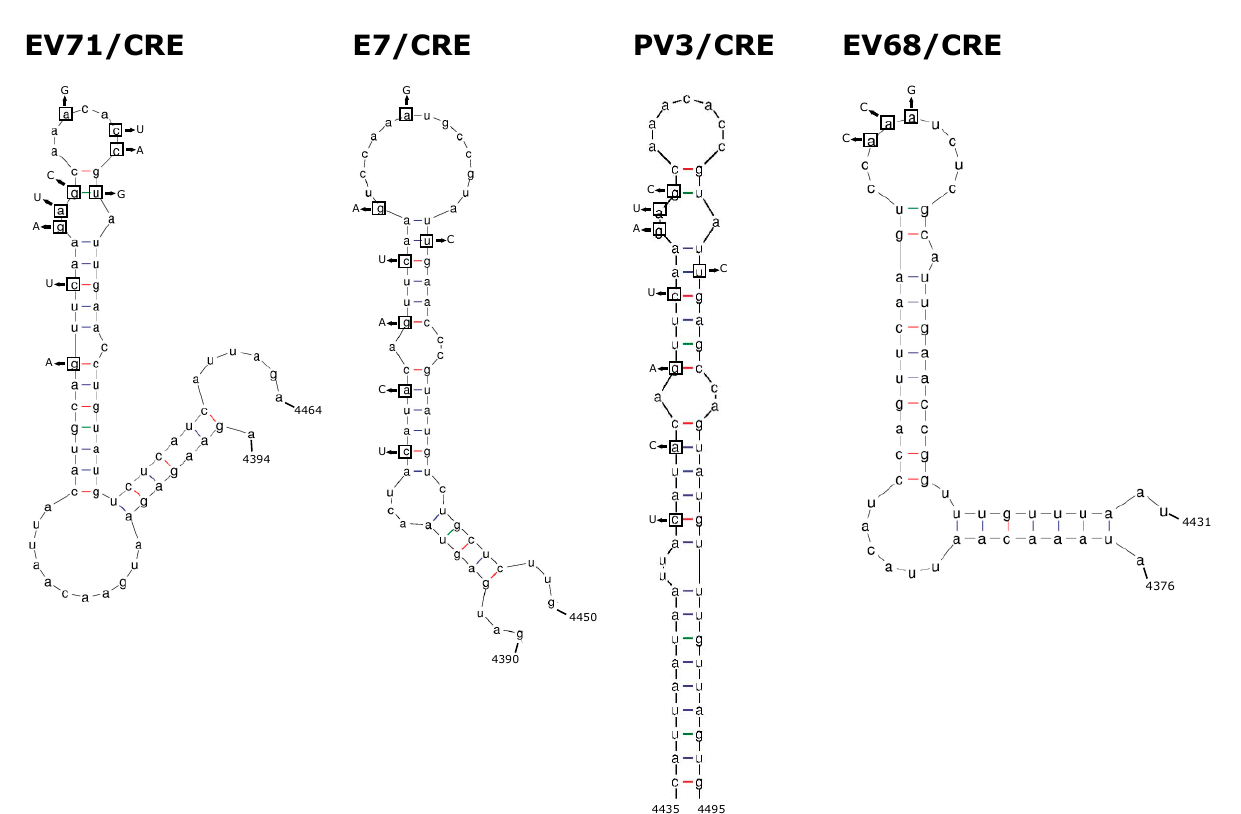
Figure 2. Representations of 2C-CRE stem-loop structures and mutations. The wild-type structure is shown for the 2C CRE of EV-A71, E7, PV3, and EV-D68. Nucleotides in boxes denote those mutated to knockout the CRE function, with replacement nucleotides shown with arrows. Table 1. Acceptor and donor templates.